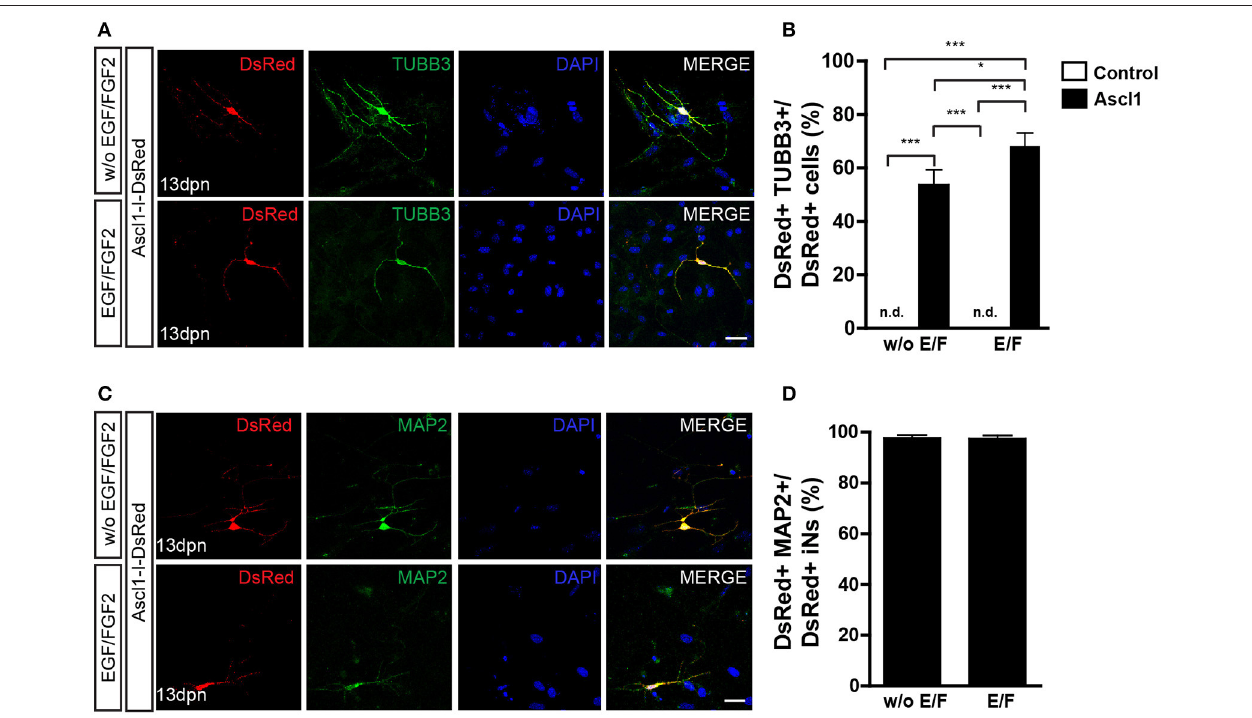
FIGURE 3 | Expression of ASCL1 converts MGCs into iNs. (A) Representative photomicrographs of MGC cultures expanded without or with EGF/FGF2 at 13 dpn with Ascl1-I-DsRed, showing DsRed + cells (red) immunolabeled for β III -TUBULIN (TUBB3, green) (B) Frequencies of DsRed + /TUBB3 + iNs amongst total DsRed + cells at 13 dpn (* p < 0.05; *** p < 0.001; Tukey’s multiple comparison test). (C) Immunolabeling of the neuronal protein MAP2 (green) in DsRed (red) cells at 13 dpn with Ascl1-I-DsRed in MGCs expanded without or with EGF/FGF2. (D) Frequencies of DsRed + MAP2 + iNs amongst all DsRed + iNs. Photomicrographs in (A,C) are single confocal Z stacks. Nuclei are stained with DAPI (blue). Scale bars: 20 µ